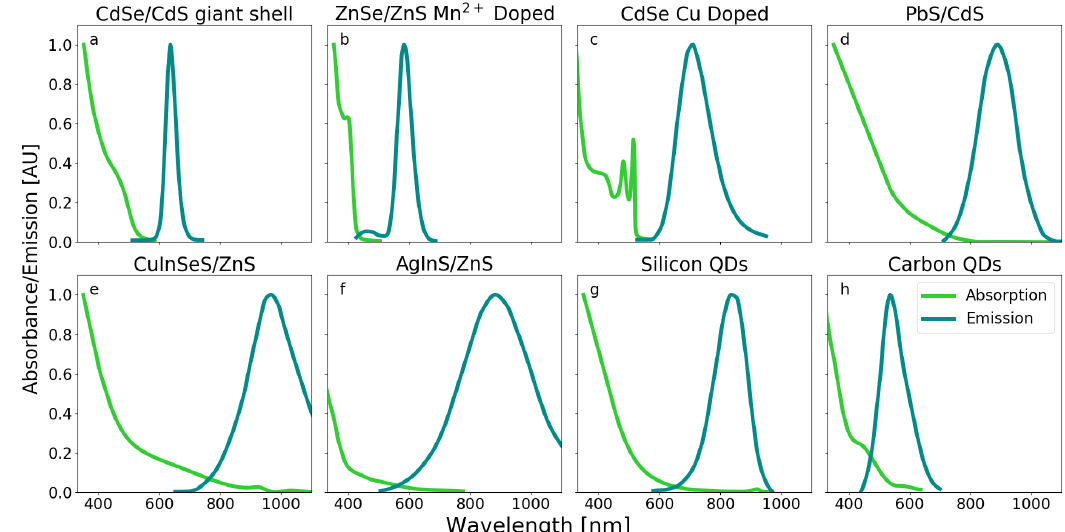
Figure 2. Absorption and emission spectra of eight different luminophore candidates for LSC